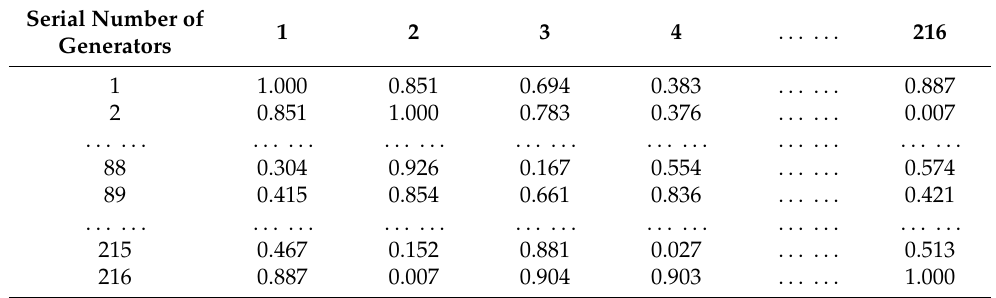
Table 3. Data of adjacency matrix M .